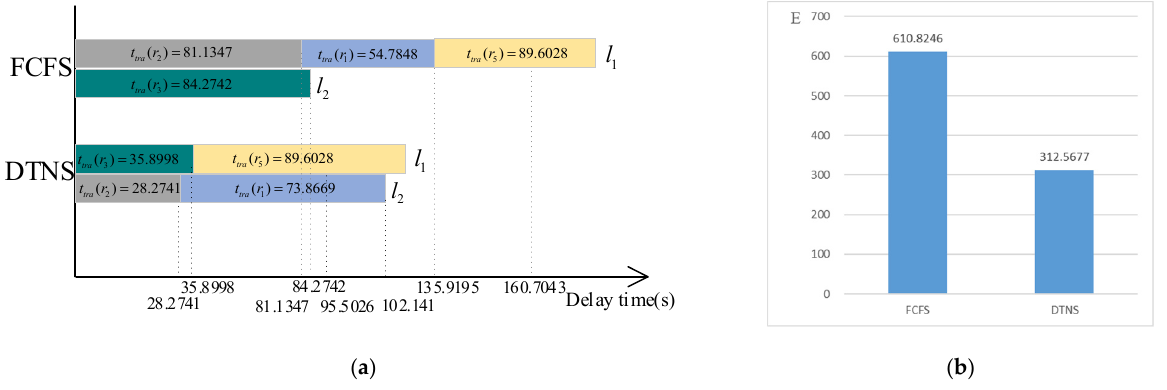
Figure 12. Comparison of efficiency under the condition of two robot-trailer in scenario 2. ( a ) Comparison of towing service time. ( b ) Comparison of delay expectations.